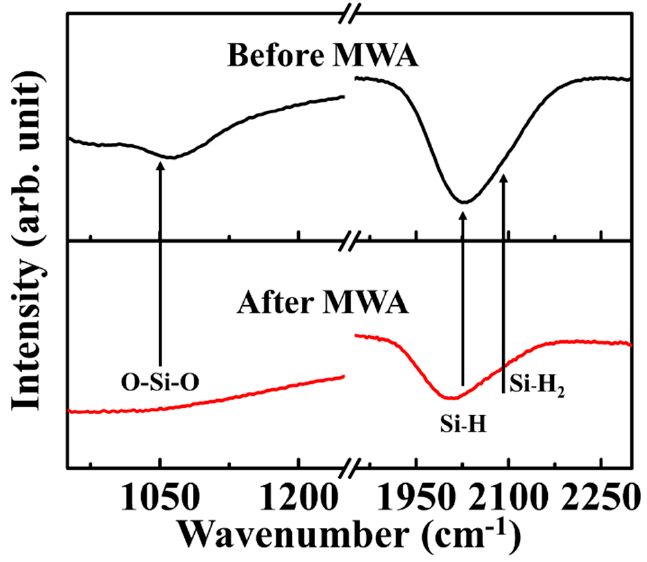
Figure 7. Fourier transform infrared spectroscopy (FTIR) of the thin film at a 0.8 Torr chamber pressure before and after using microwave annealing.